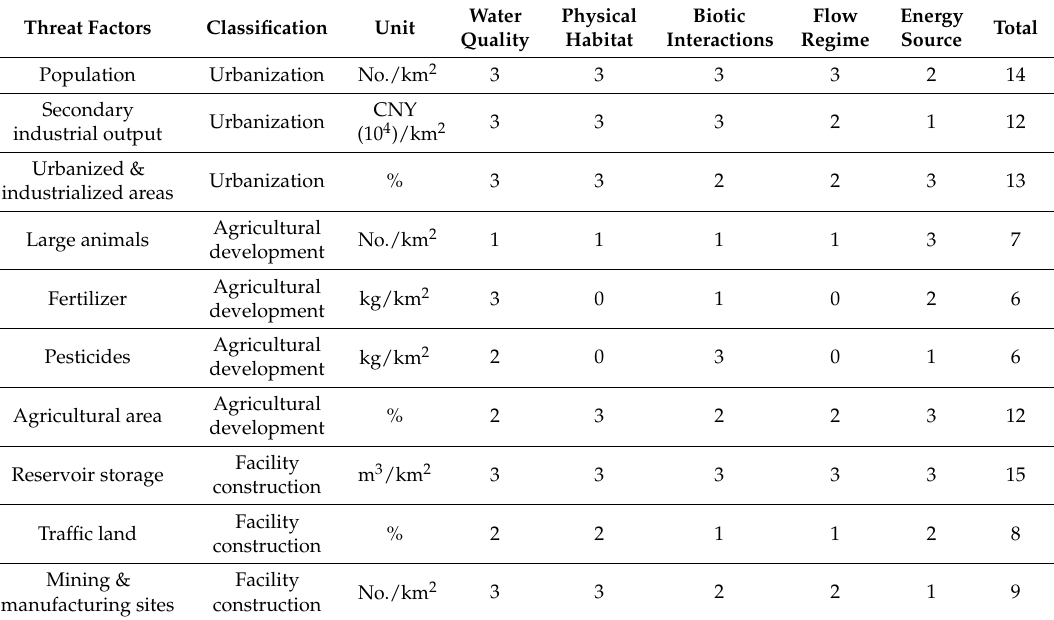
Table 1. Threat severity weightings assigned to individual threat